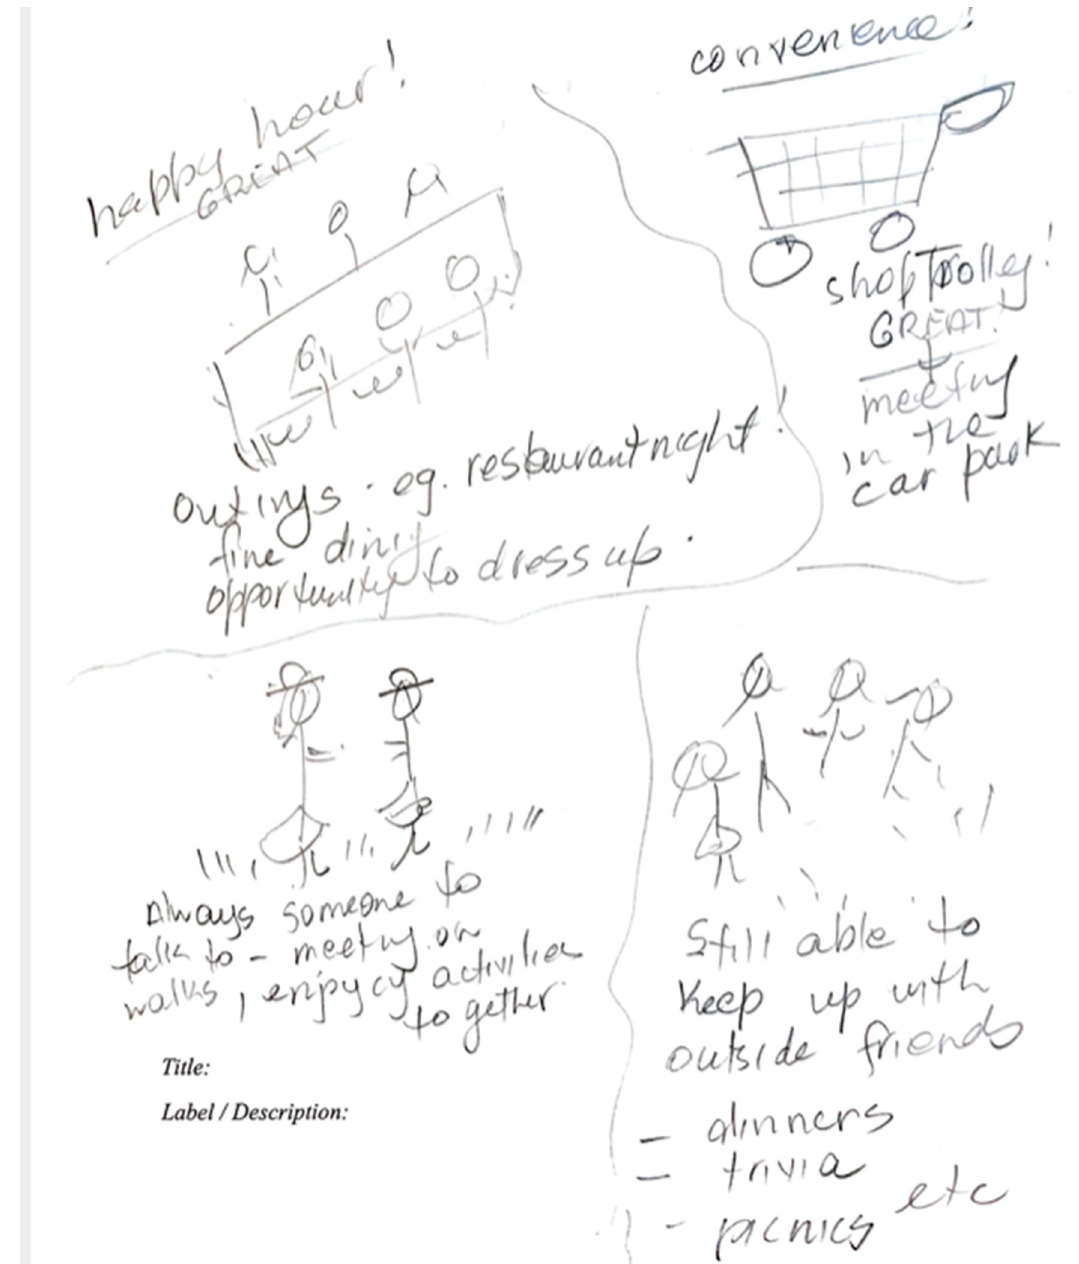
Figure 6. Jill was very much enjoying the social retirement village lifestyle.